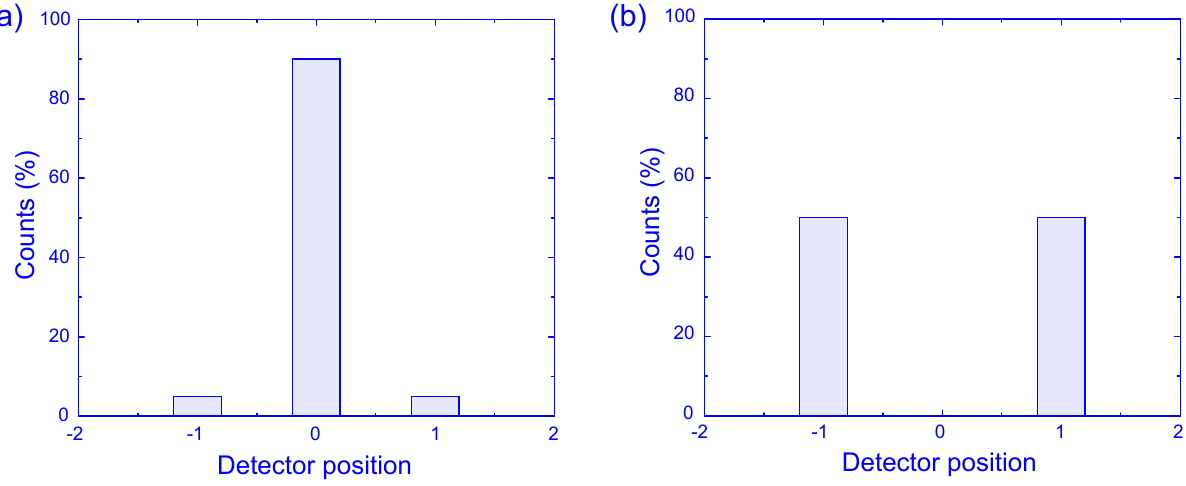
Figure 5: Results that the detectors measuring the z-component of spin B are expected to show (a) without coincident counting, and (b) with coincident counting with the central detector after the Stern-Gerlach magnetic field along the y -axis in the path of particle A. Here, detector positions − 1 , 0 , + 1 correspond to eigenvalues + 1 , 0 and − 1 of the measured spin